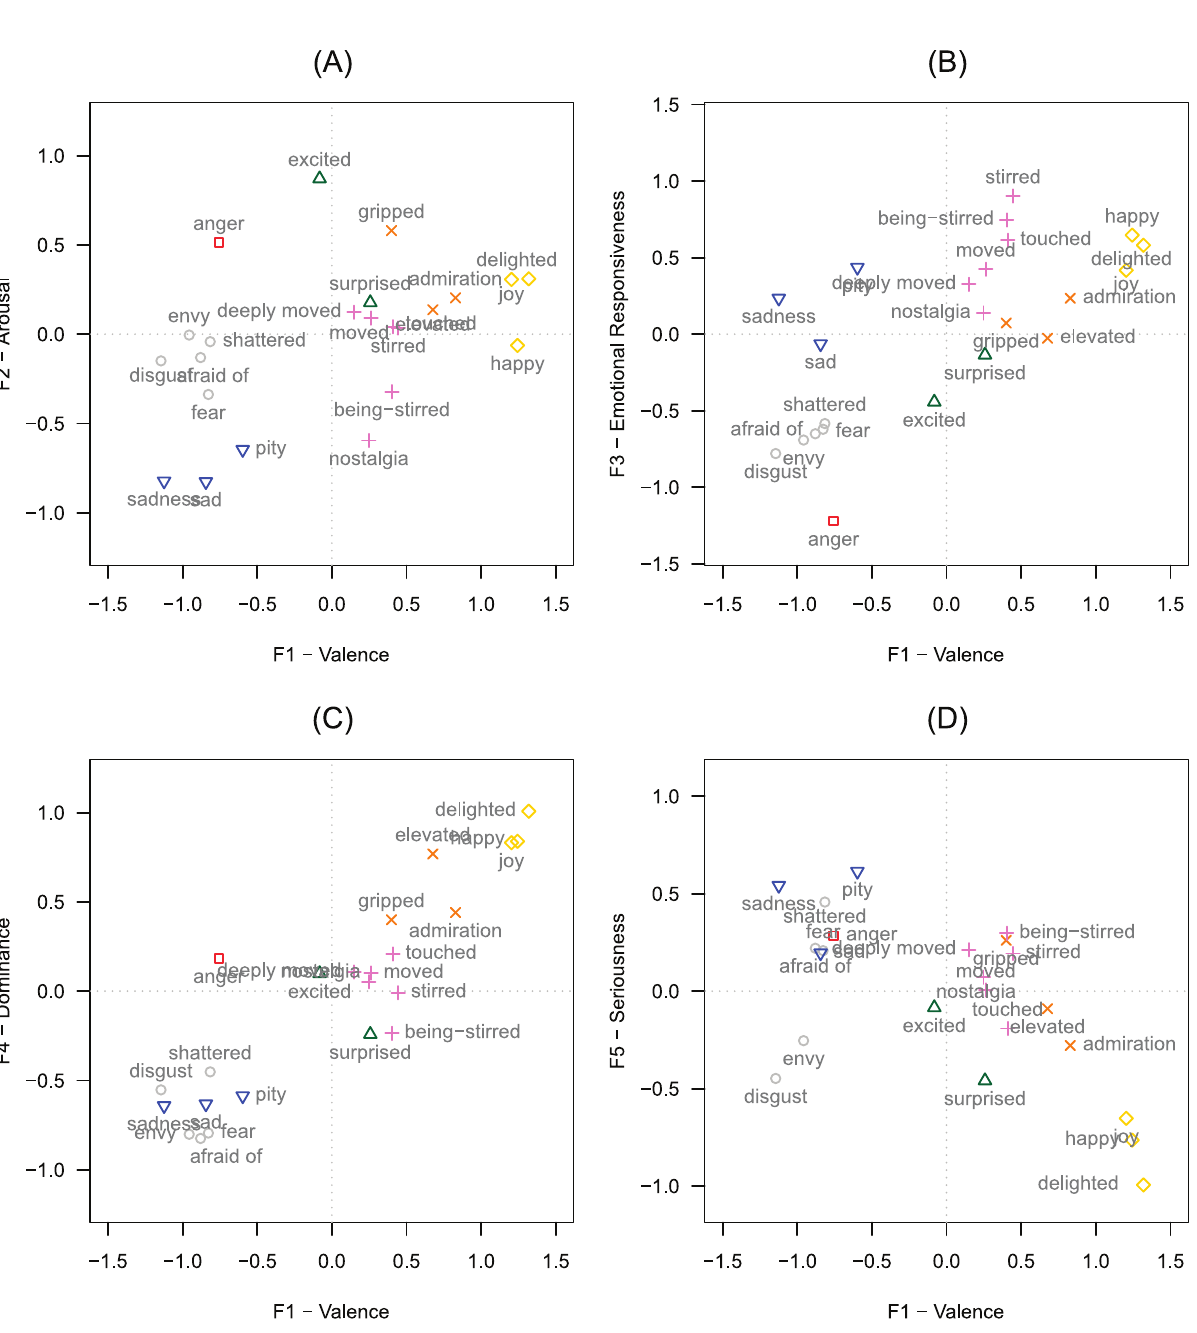
Fig 5. The five dimensions of the exploratory factor analysis of Study 3. The 23 emotion terms used in Study 3 are depicted along the five dimensions revealed by the exploratory factor